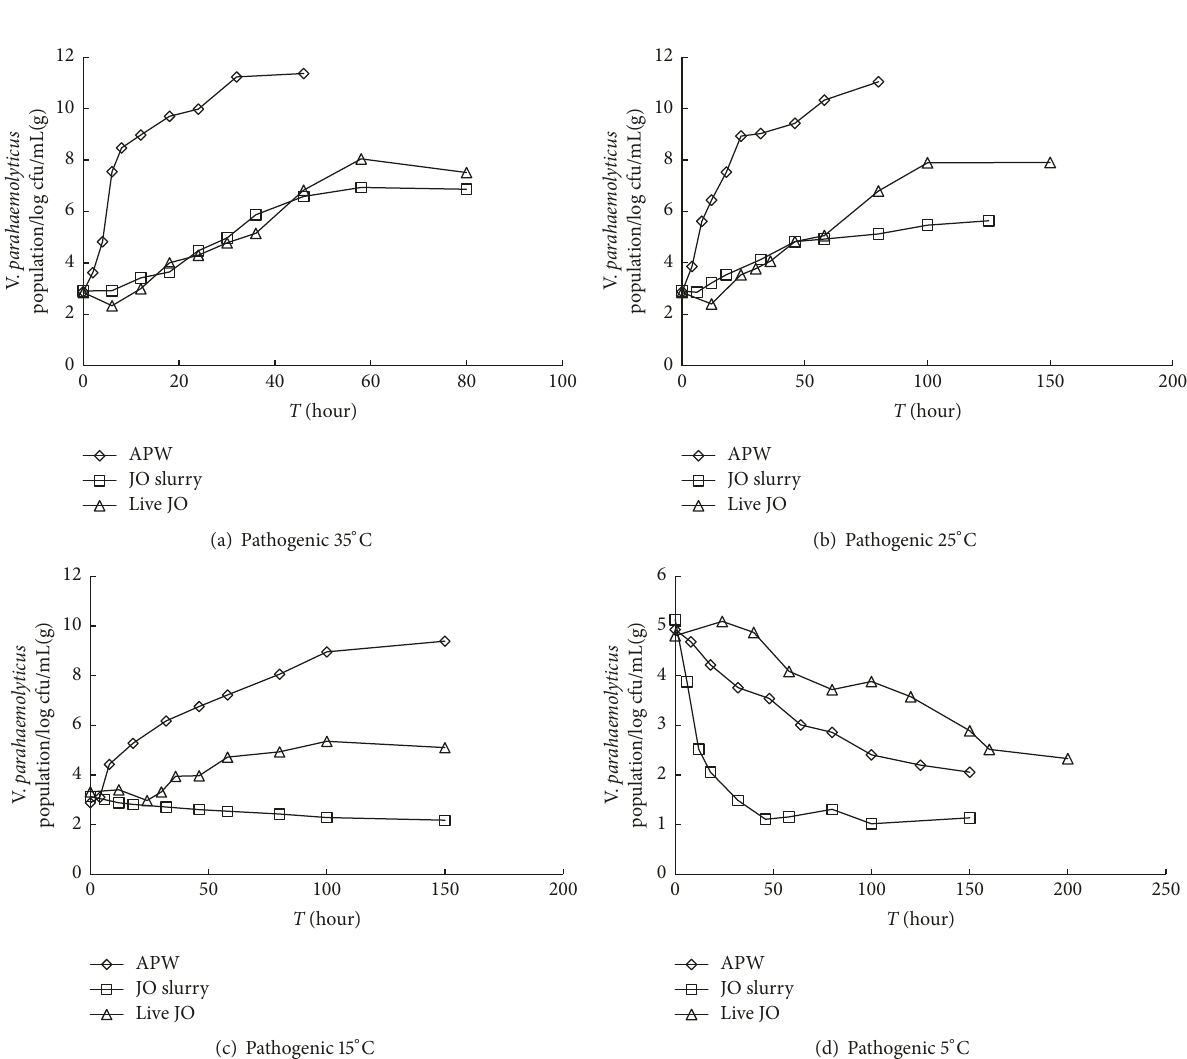
Figure 1: Comparison of growth profile of the multiple strains of pathogenic V. parahaemolyticus in APW, JO slurry, and JO at (a) 35 ∘ C, (b) 25 ∘ C, (c) 15 ∘ C, or (d) 5 ∘ C obtained through DLAP